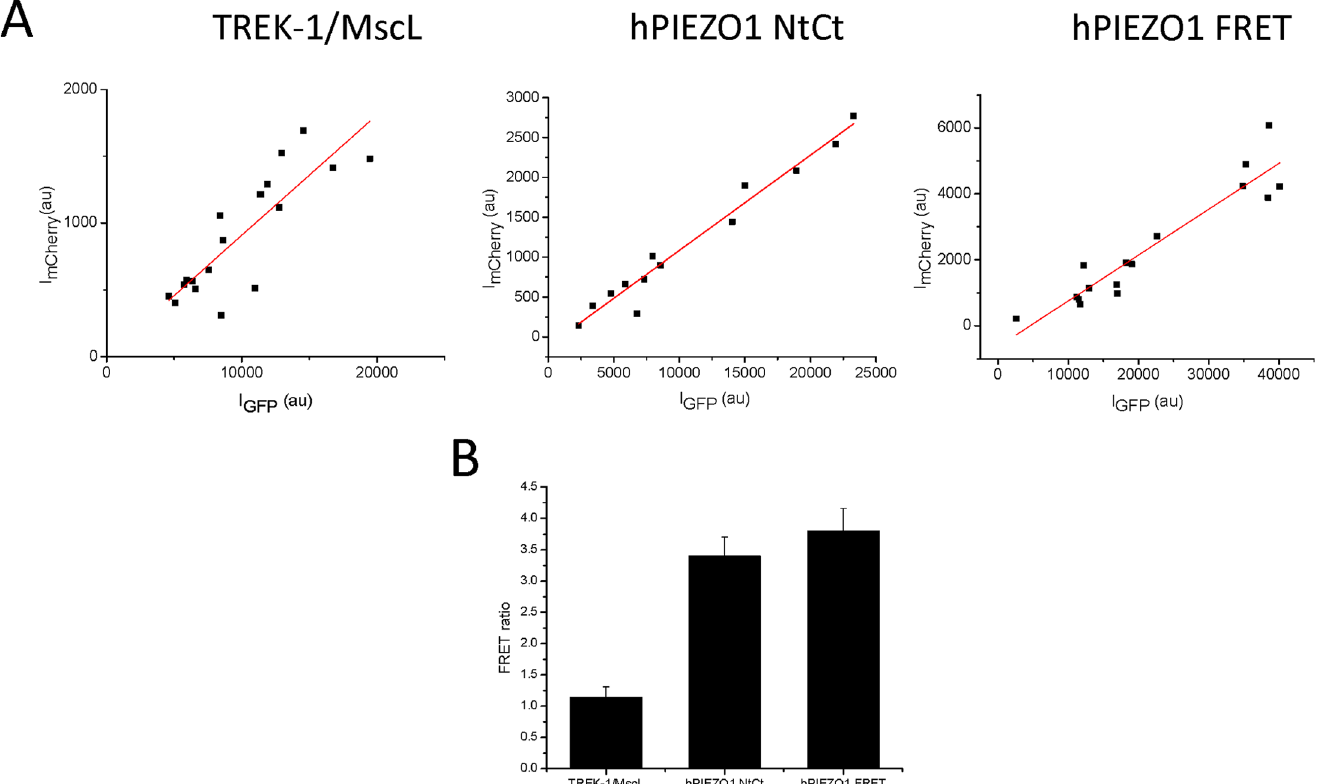
Fig 6. Energy transfer between the two protein segments demonstrates that they are in close proximity. The two fluorophores used to tag the protein segments have spectral overlap,allowing us to measure their proximity by measuring energy transfer (FRET). We transfected HEK293 cells with bicistronic plasmid TREK1-mCherry/MscL-EGFP and hPIEZO1 Nt-mCherry/Ct-EGFP and the hPIEZO1-FRET fusion protein. We measured the emissions of EGFP (525nm) and mCherry (680nm) for multiple cells from each transfection and plotted them in Panel A . The data from each transfection were fit by linear regression showing slopes of TREK1/MscL – 0.09, hPIEZO1 NtCt – 0.13, and hPIEZO1 FRET – 0.12. The amount of energy transfer between the two fluorophores was determined by the ratio of the 680nm emission excited at 470nm and 560nm ( Panel B ). The ratio of TREK-1/MscL proteins was 1.15 ± 0.17 (n = 18, error bars are S.D.). The ratio for the linked fluorophores in cells expressing hPIEZO1 FRET fusion protein had a value of 3.8 ± 0.37 (n = 16, error bars are S.D.). The ratio for the split protein monomers was 3.4 ± 0.3 (n = 14, error bars are S.D.), which is close to the hPIEZO1 FRET ratio, suggesting the monomers are in close